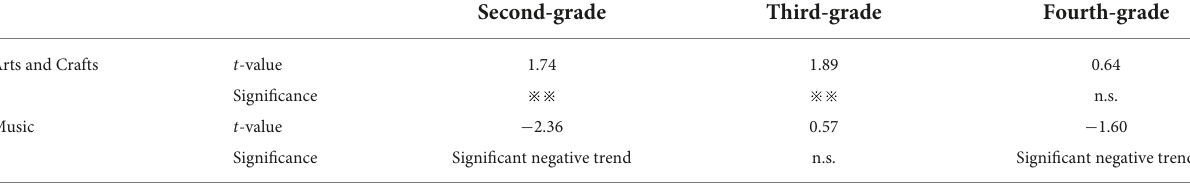
TABLE 6 Differences in performance in arts and crafts and music skills and changes in significant differences in softball throwing task records by